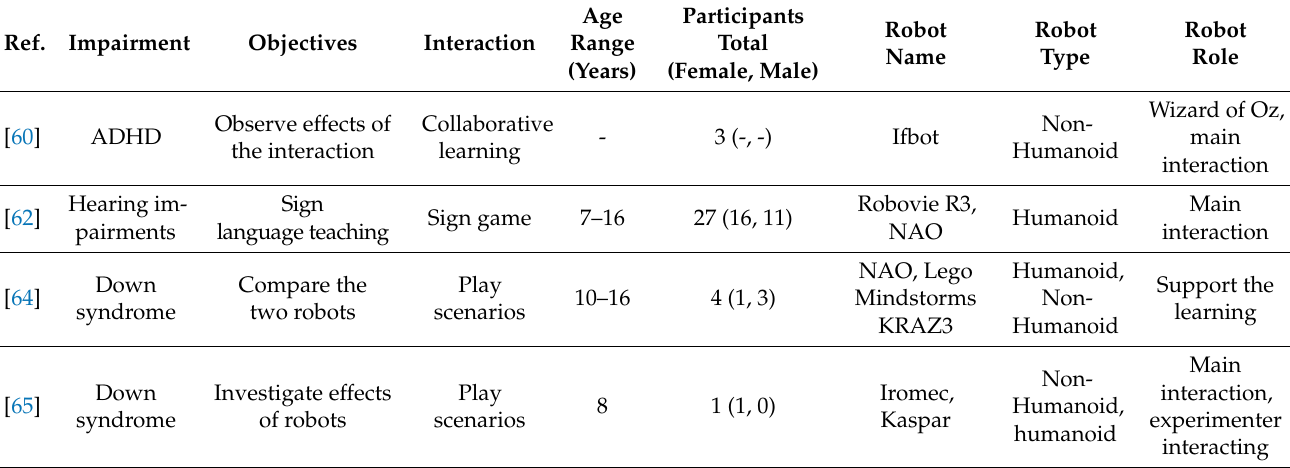
Table 4. Quantitative information of the examined studies with miscellaneous impairments.